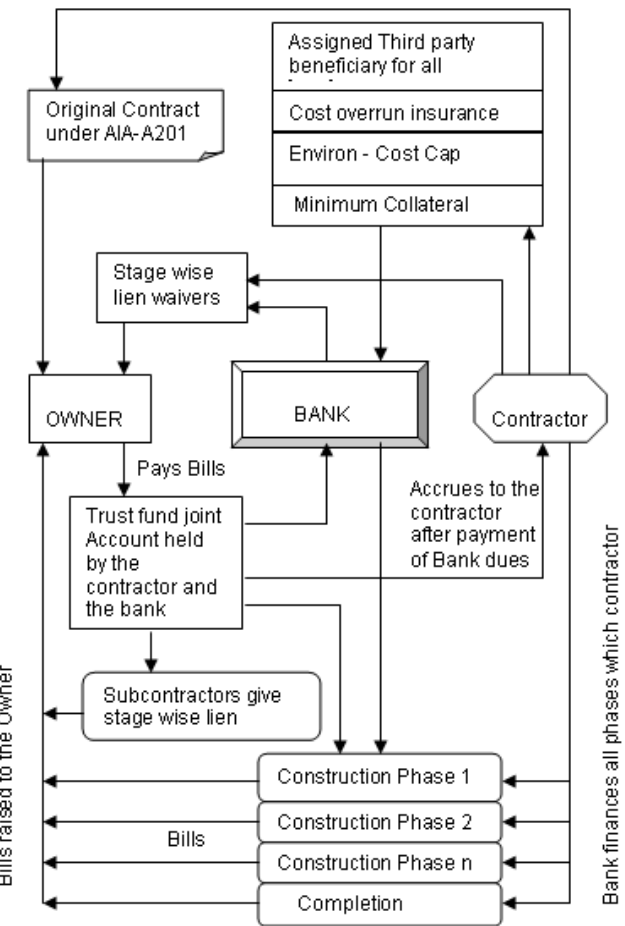
Figure 2 : The New Project Finance